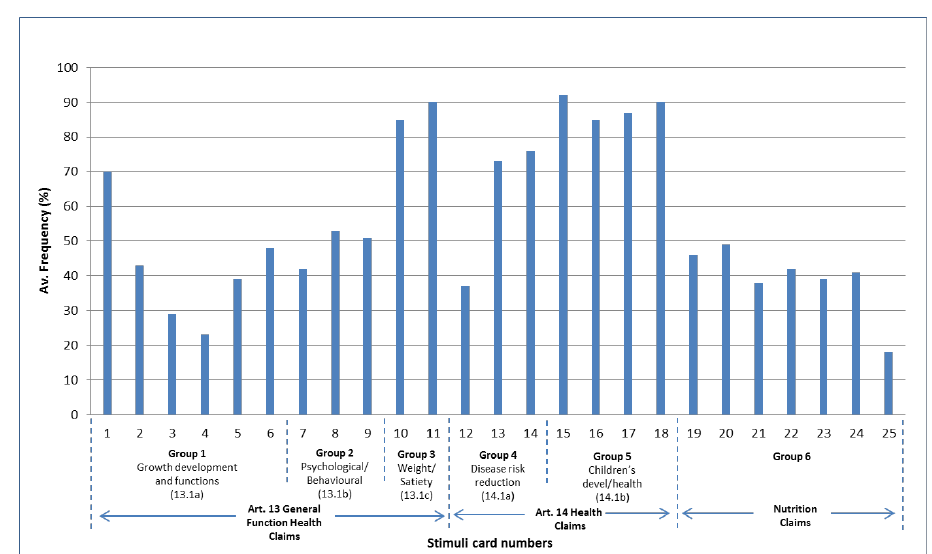
Figure 7. Average frequency (%) of placement in appropriate structured sort groups across all countries. See Table 2 for the claims associated with the stimuli card numbers.